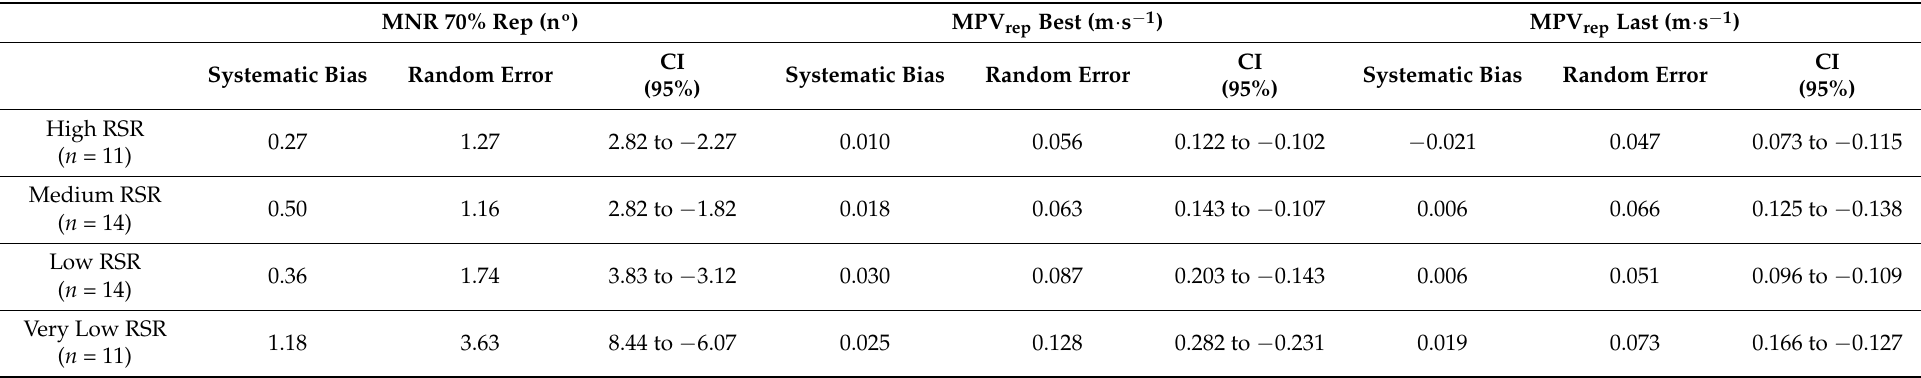
Table 3. Bland–Altman plots of intra-individual variability (test (T2)-retest (T3)) of the number of repetitions performed before failure (MNR), MPV rep Best, and MPV rep Last on two different days according to